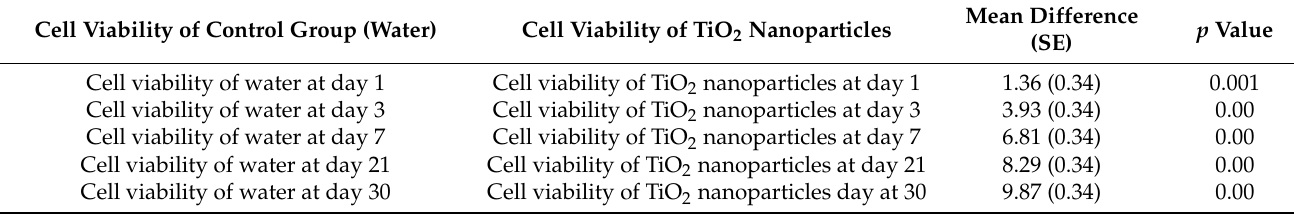
Table 1. Comparison of cytotoxicity analysis between control group and TiO 2 nanoparticles synthe- sized by Bacillus subtilis at various days with SE (Standard Error).